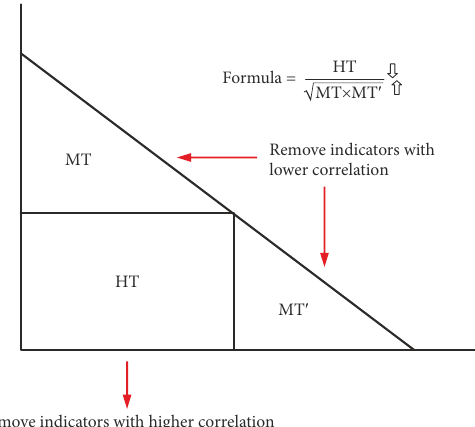
Figure 3. Reduction of HTMT ratios in the correlation matrix (source: own elaboration based on Hair et al., 2017; Henseler et al.,